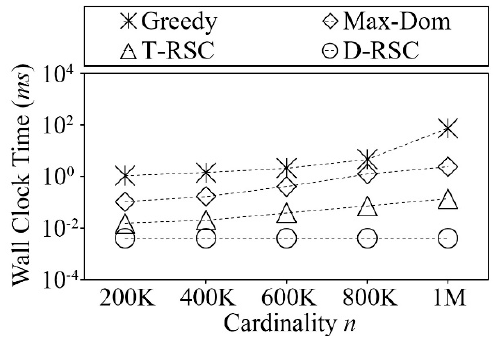
Figure 11. Comparison of re-computation time on synthetic dataset (varied | P |).